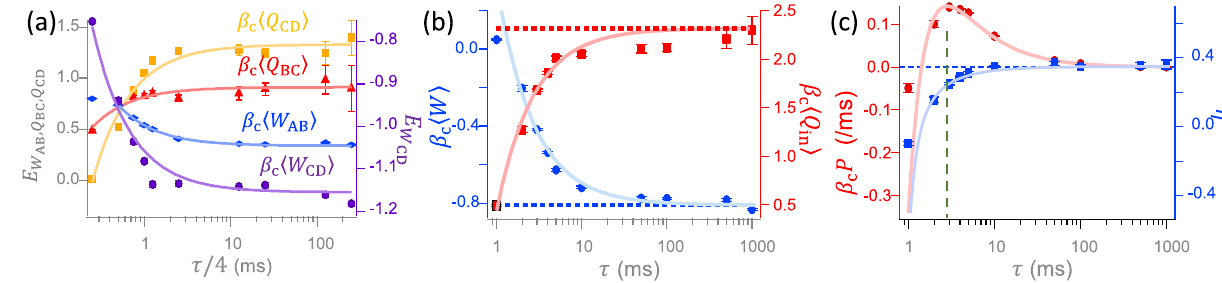
W AB Figure 6. Energetics of the microscopic Stirling engine. ( a ) The experimentally attained β c (blue (cid:31) (cid:30) W CD Q BC Q CD diamonds), β c (purple circles), β c (red triangles), and β c (yellow squares) are fitted by four (cid:31) (cid:30) (cid:31) (cid:30) (cid:31) (cid:30) 1 /τ const. , where the values of β c W AB Q BC Q CD W CD functions of the form f (τ) , β c , and β c ( β c ) = ± + (cid:31) (cid:30) (cid:31) (cid:30) (cid:31) (cid:30) (cid:31) (cid:30) are presented on the left (right) axis labeled by E W ( E W ). Therein, the blue line is not connected to AB , Q BC , Q CD CD the leftmost blue point, because work does not obey the above 1 /τ relation in this small τ regime, as observed β c ( ) , (red W W AB W CD in several of our experiments. ( b ) The dimensionless average total work, β c � � = � � + � � β c ( β c ) , (blue squares) over a cycle are fitted by two functions Q Q BC Q CD circles) and injected heat, β c � � = � � + � � β c /τ , (red circles and line) and the engine W of the same form as f (τ) . ( c ) The rescaled power output, β c P = � � / W Q efficiency, η , (blue squares and line), where symbols are calculated from the data in ( b ) and the = −� � � � 2.8 ms (green dashed line and the lines are given by Eqs. (6) and (7), respectively. The power has a peak at τ ≈ 0.35 , (horizontal blue dashed line) in the quasi-static limit τ efficiency saturates at its maximum, η . → ∞ ∞ ≈ The errors in all symbols from ( a ) to ( c ) are the 95 % confidence